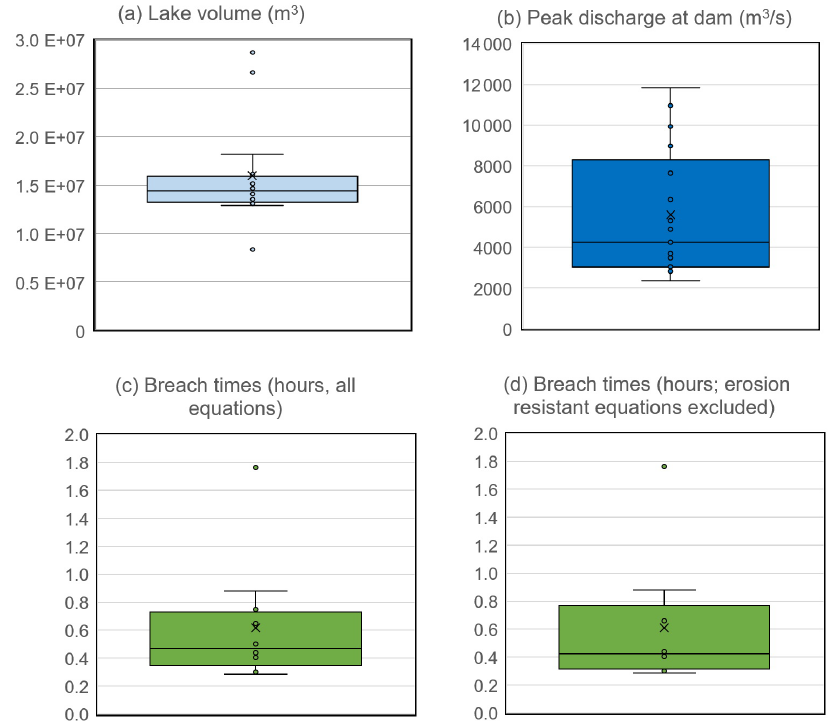
Figure 8. Lake, dam breach, and flood parameters, derived from sets of published empirical relationships. (a) Volume of Jinwuco. (b) Peak discharge at the dam. (c) Breach time, considering all available equations. (d) Breach time, considering only those equations derived for easily erodible dams (an assumption we consider likely to hold for the dam of